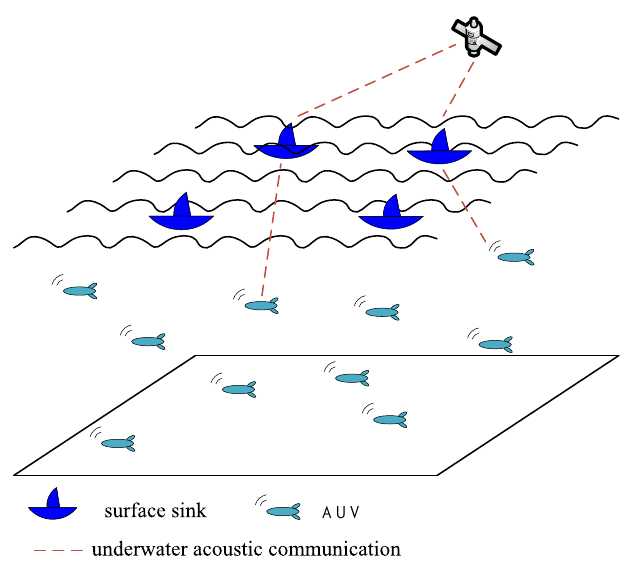
Figure 1. Underwater mobile sensor network system